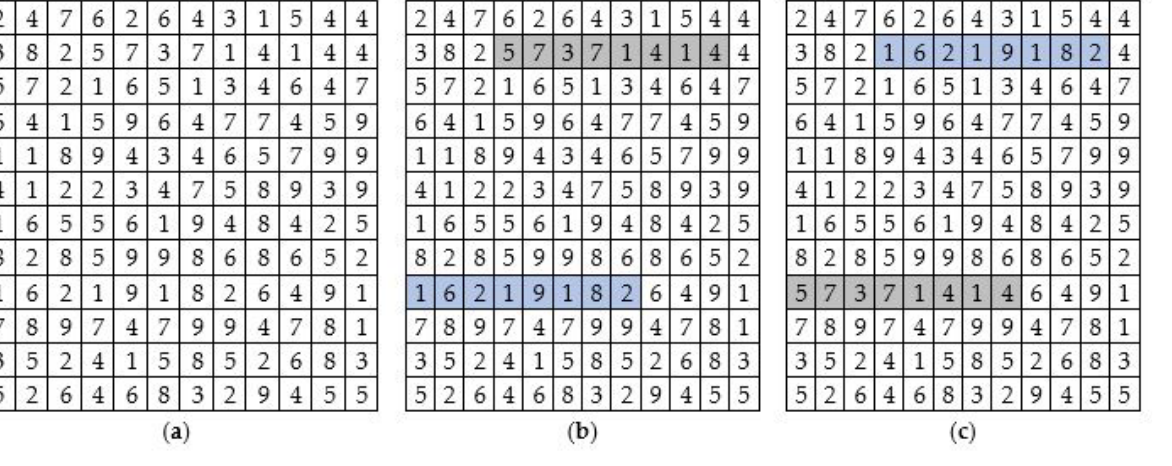
Figure 2. Block-swapping row-wise: ( a ) the initial state of the image; ( b ) the highlighted blocks; ( c ) the state of the image in ( a ) after block-swapping.